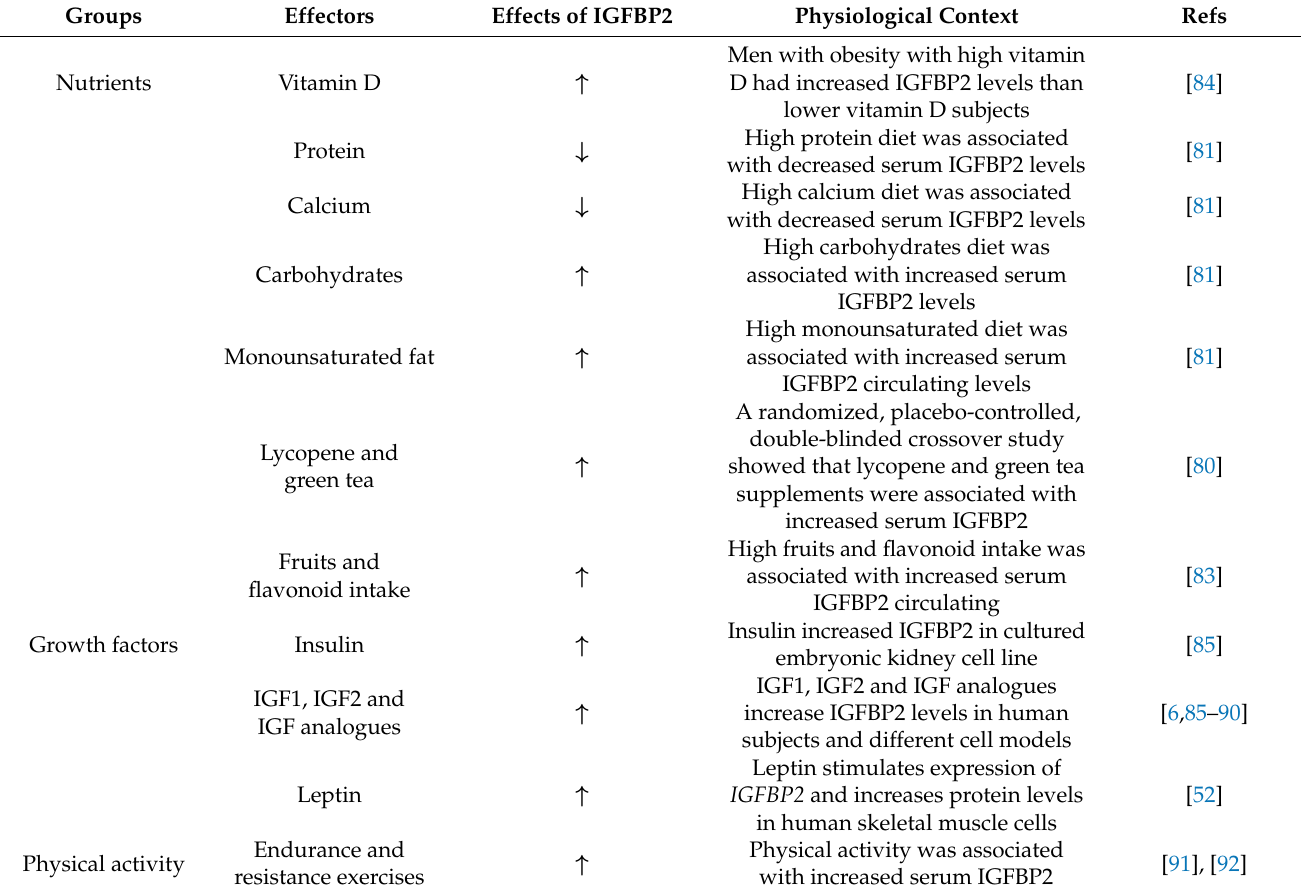
Table 1. Dietary and lifestyle components that alter the circulating levels of